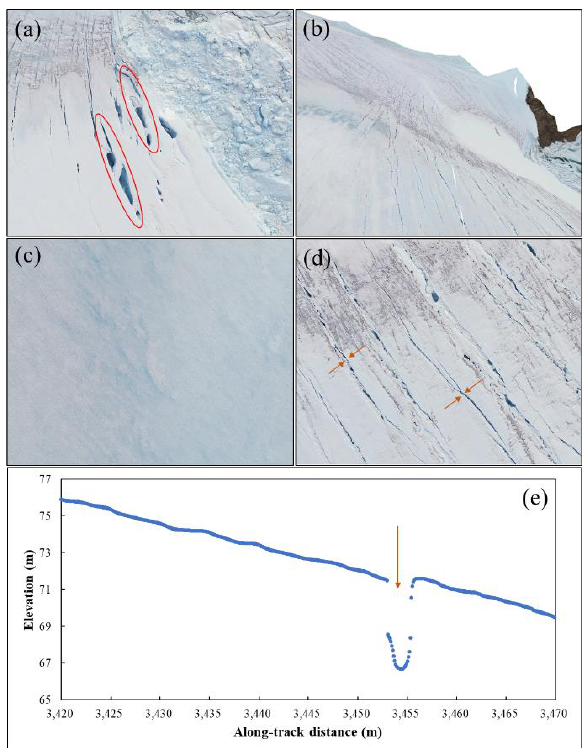
Figure 5 . (a) (b) Calving and retreat trend at ice sheet front; (c) micro-topography of inland ice sheet; crevasses displayed on images (d) and DSMs (e).